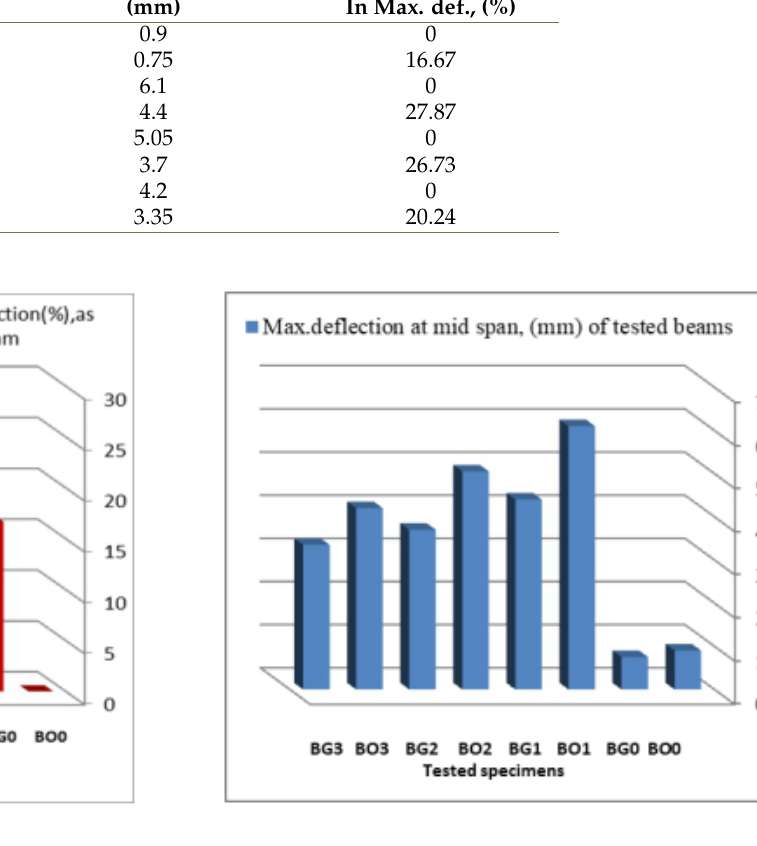
Fig. 10. Maximum Deflections value at mid